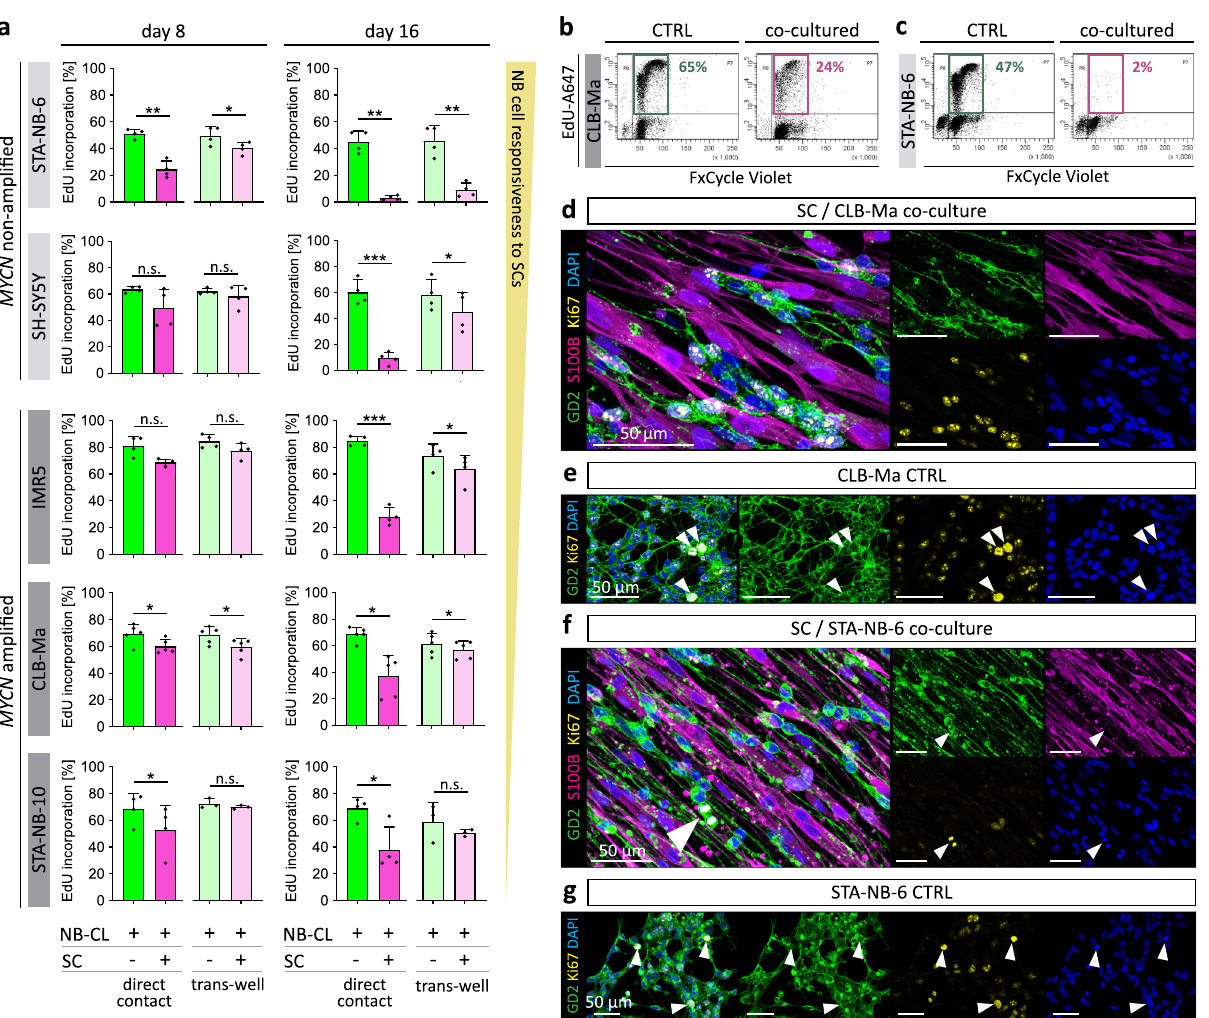
Fig. 5 Proliferation analysis of neuroblastoma cell lines after direct and indirect contact to repair-related SCs in vitro. Three NB cell lines and two NB cell short-term cultures were co-cultured with primary repair-related SCs and their proliferation rates were analyzed by FACS and IF. a Bar diagrams show the mean percentage of EdU-incorporation ± SD in GD2 + /S100B - NB cells upon direct co-cultures (STA-NB-6, p = 0.008; SH-SY5Y, p = 0.139; CLB-Ma, p = 0.025; IMR5, p = 0.073; STA-NB-10, p = 0.023) and trans-well co-cultures (STA-NB-6, p = 0.006; SH-SY5Y, p = 0.401; CLB-Ma, p = 0.032; IMR5, p = 0.051; STA- NB-10, p = 0.209) with SCs at day 8 as well as direct co-cultures (STA-NB-6, p = 0.003; SH-SY5Y, p = 0.001; CLB-Ma, p = 0.019; IMR5, p = 0.001; STA-NB- 10, p = 0.037) and trans-well co-cultures (STA-NB-6, p = 0.015; SH-SY5Y, p = 0.042; CLB-Ma, p = 0.039; IMR5, p = 0.028; STA-NB-10, p = 0.472) with SCs at day 16; STA-NB-6: n = 4; SH-SY5Y: n = 4; CLB-Ma: n = 5; IMR5: n = 4; STA-NB-10: direct co-cultures n = 4, trans-well cultures n = 3; A paired two-tailed Student ’ s t-test comparing against the control was performed. * p ≤ 0.05; ** p ≤ 0.01; *** p ≤ 0.001. Representative FACS plots illustrate EdU incorporation and the DNA content of control and co-cultured NB cells ( b ) CLB-Ma and ( c ) STA-NB-6 at day 16; the marked EdU + /FxCycleViolet + cells are in the S-Phase of cell cycle. FACS gating strategy is detailed in Supplementary Fig. 7b. n refers to the number of independent experiments. Representative IF images of co-cultured CLB-Ma ( d ) and STA-NB-6 ( f ) cells stained for Ki67, S100B, GD2 and DAPI at day 11 of direct co-culture and respective NB cell controls stained for GD2, Ki67, and DAPI ( e , g ); arrows indicate NB cells undergoing mitosis. Stainings were performed on NB cell controls and corresponding co-cultures with SCs derived from three independent